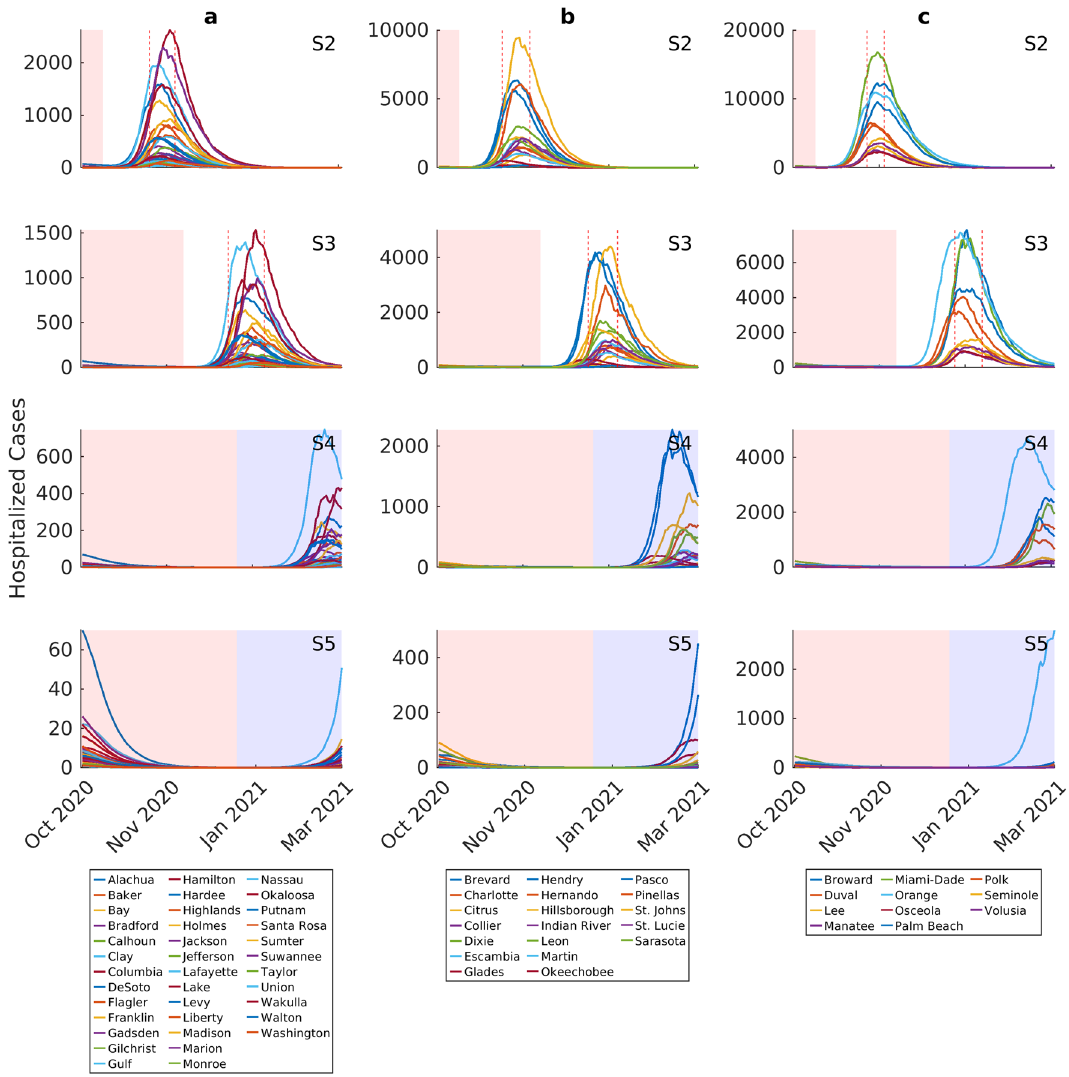
Figure 4. Forecasts of corresponding hospitalized cases for individual counties under the four different social intervention scenarios. Hospitalized cases include both hospital and ICU model compartments. Note the differences in y-axis values when comparing scenarios. Each curve represents the median prediction for a given county. The results are stratified by initial county-level incidence growth rate (Group a < 0.05, Group b > 0.05–0.15, Group c > 0.15). The intervention scenarios are as follows (also see Supplementary Fig. S2): S2: maintain movement estimate and social distancing measures over 2 weeks from October 1st to October 14th; S3: maintain movement estimate and social distancing measures over 8 weeks from October 1st to November 30th; S4: maintain movement estimate and social distancing measures through end December 2020 + begin low intensity contact tracing and quarantine efforts on October 1st through March 2021; S5: maintain movement estimate and social distancing measures through end December 2020 + begin high intensity contact tracing and quarantine efforts on October 1st through March 2021. The red shading in each plot indicates the duration of movement and social distancing in each scenario, while the blue shading shows quarantining measures without movement or social distancing. The range of peak hospitalized cases for each group is shown by dotted vertical lines. For scenario 2, the peak of hospitalized cases occurs between November 9th–November 24th for Group